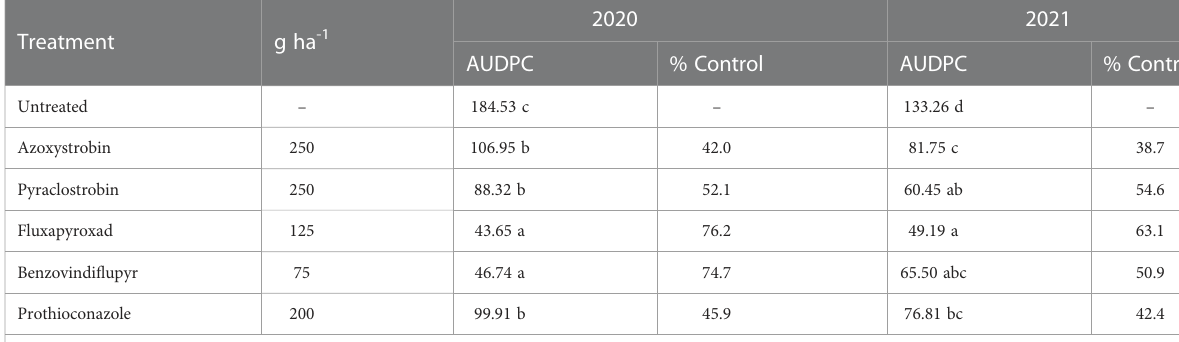
TABLE 5 The area under disease progress curve (AUDPC) of winter wheat infected by Z. tritici in 2020 and 2021.